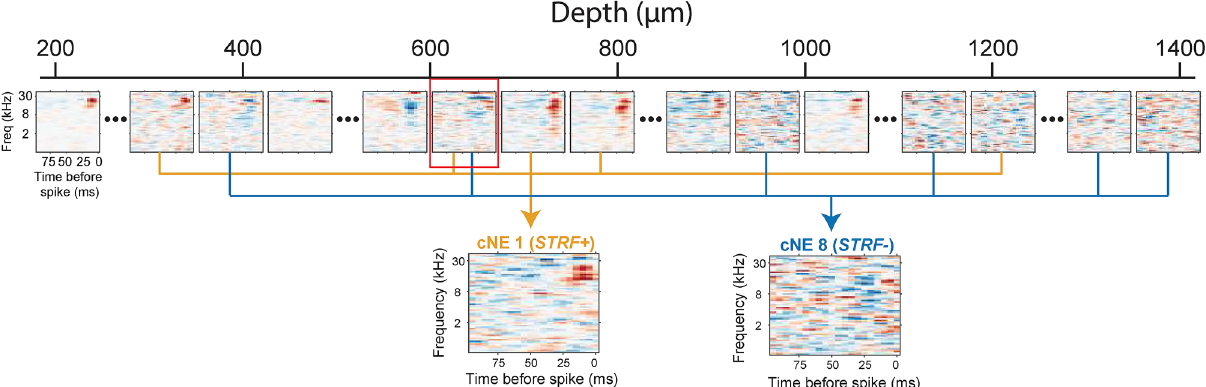
Figure 1. Example penetration with two sample cNEs. STRF +: neurons or cNEs with significant STRFs. STRF− : neurons or cNEs with non-significant STRFs. Depth of some neurons and their respective STRFs are shown. Two example cNEs are represented. cNE 1 (orange, STRF +) is mostly made up of STRF + neuronal members. cNE 8 (blue, STRF− ) is mostly made up of STRF− neuronal members. One neuron, highlighted with a red square at a depth of approximately 600 µm, is part of both cNE 1 and cNE